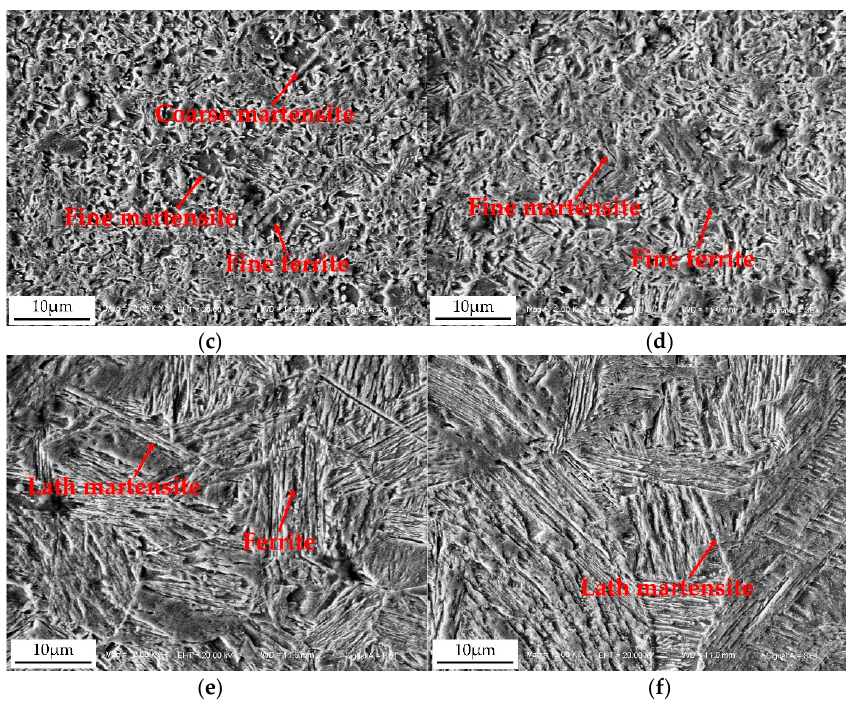
Figure 9. Microstructure of ( a ) different zones of the welded joint; ( b ) base metal; ( c ) uneven structure zone; ( d ) fine grain zone; ( e ) superheated zone; ( f ) weld nugget zone.